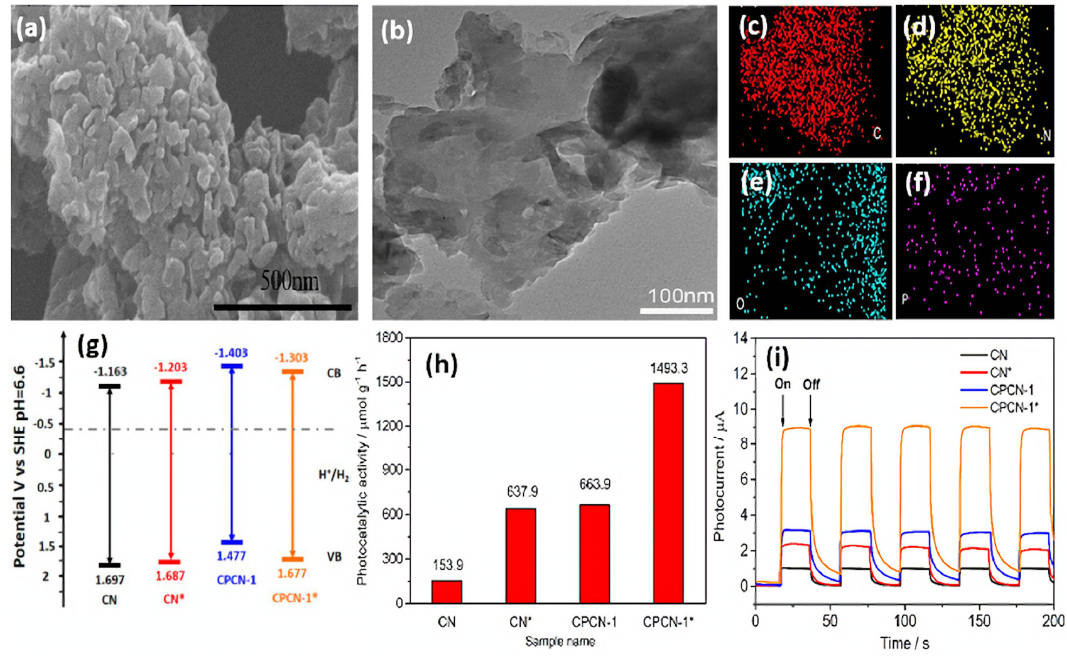
Figure 11. ( a ) SEM image, ( b ) TEM image, and ( c – f ) element mapping analysis of CPCN-1*. ( g ) Elec- tronic band gap structure, ( h ) H 2 production rate, and ( i ) transient photocurrent responses of CN, CN*, CPCN-1, and CPCN-1*. Adapted with permission from Ref. [154]. 2017, American Chemical Society.